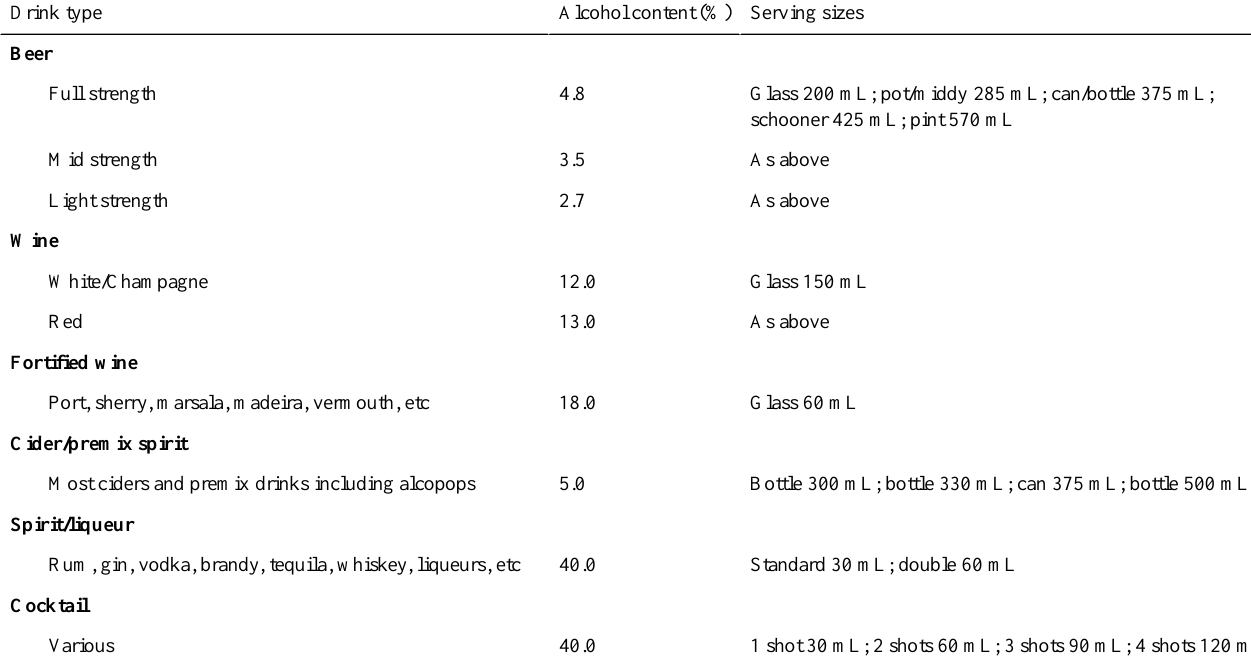
Table 1. Drink types, alcohol content, and serving size options available in the CNLab-A